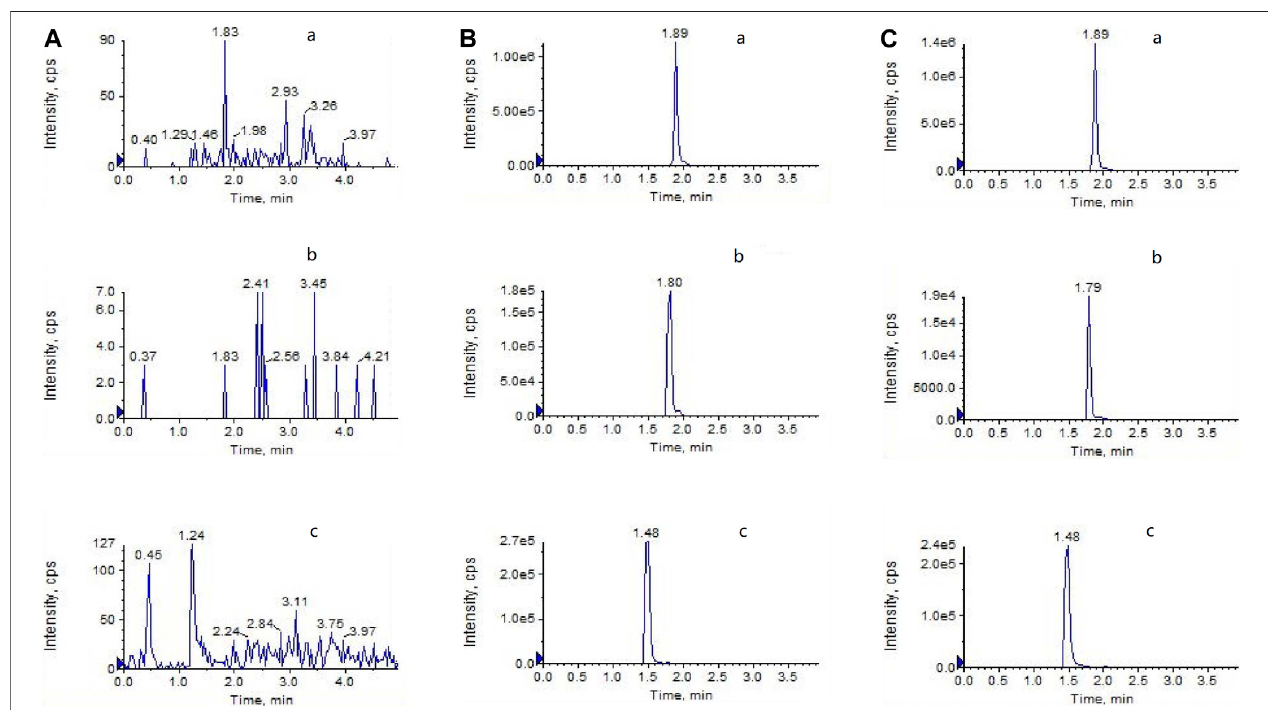
FIGURE 1 | LC-MS/MS chromatograms of (A) blank plasma (B) blank plasma spiked with LPV (3,000 ng/ml), RTV (300 ng/ml), and indinavir as the IS (100 ng/ml) (C) plasma at 3 h after oral administration of LPV/RTV (42:10.5 mg/kg).